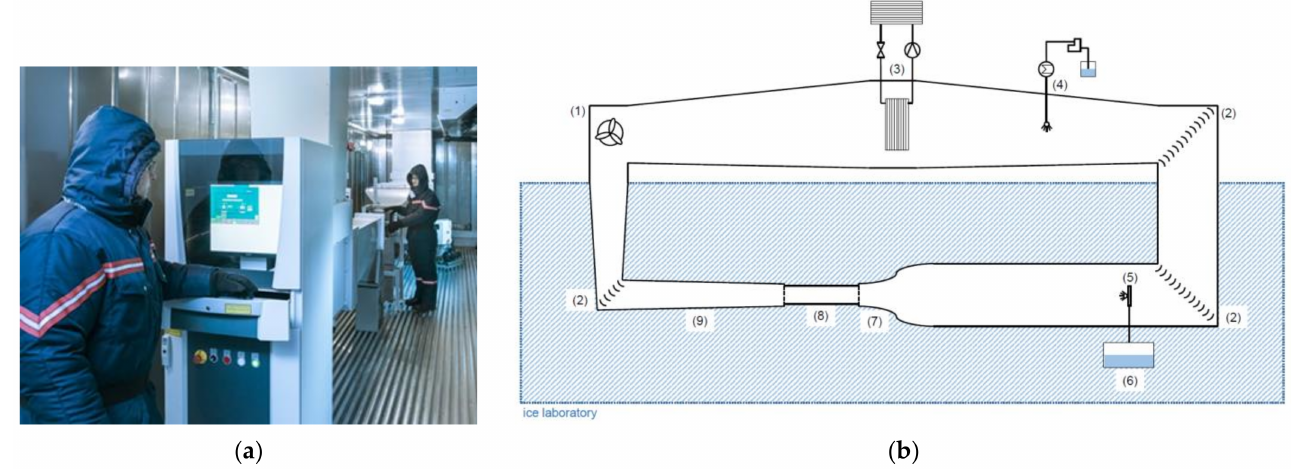
Figure 1. View inside the Fraunhofer IFAM ice lab ( a ) and scheme of the closed-loop ice wind tunnel ( b ) with a fan drive system (1), turning vanes (2), heat exchanger of refrigeration system (3), humiditystat (4), water spray bar (5), water reservoir and pumps (6), test section entrance (7), test section (8), and diffusor